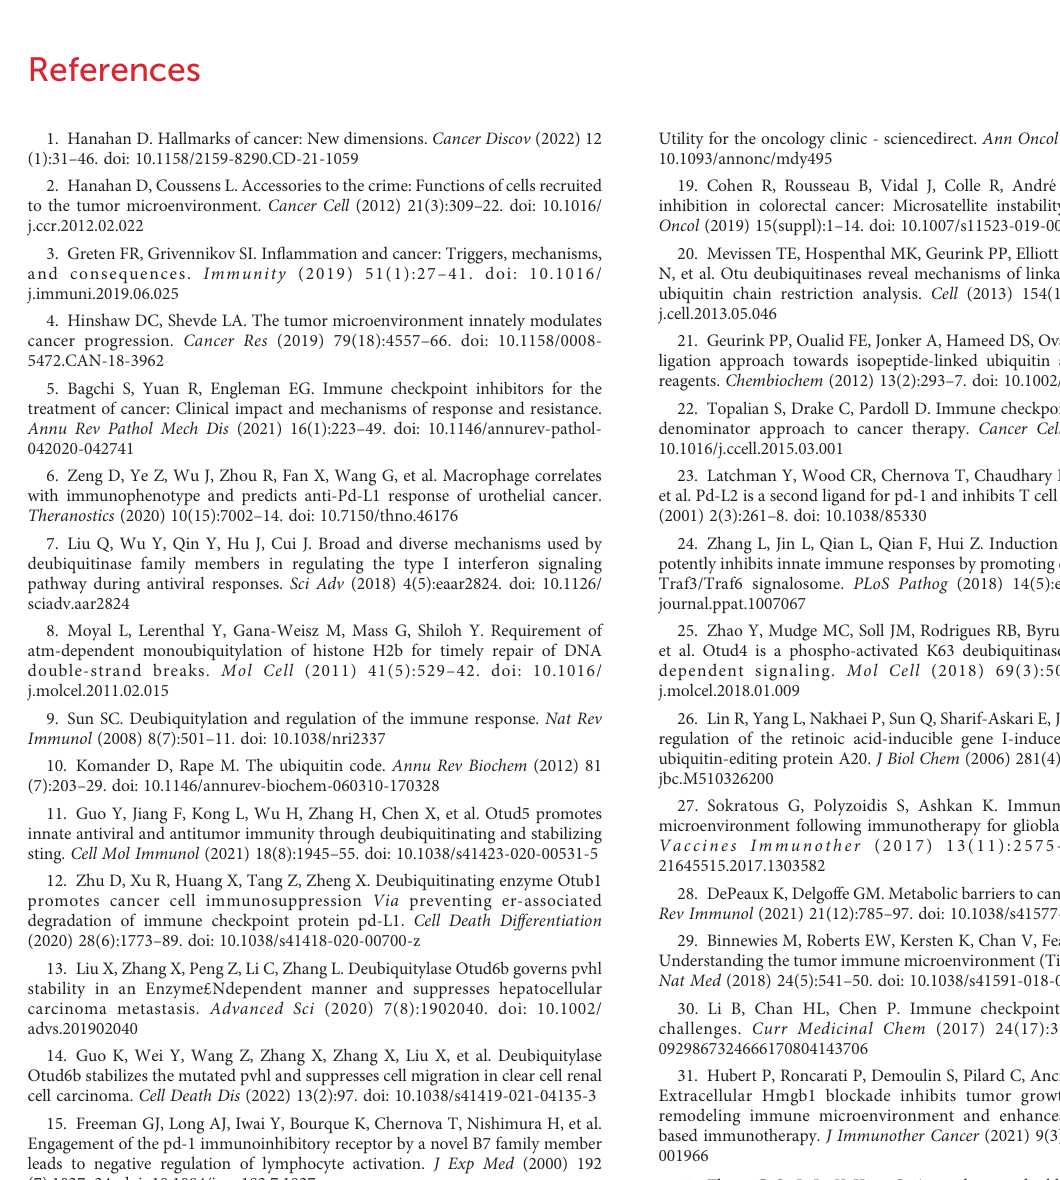
SUPPLEMENTARY FIGURE 1 Gene mutation pro fi les of OTUD6B in pan-cancer. (A) The expression differences of OTUD6B between normal and tumor tissues from TCGA database. (B) Gene alteration (C) Copy number variation of OTUD6B expression. (D) Mutant landscape of OTUD6B. SUPPLEMENTARY FIGURE 2 Protein expression and location of OTUD6B in normal and tumor tissues.